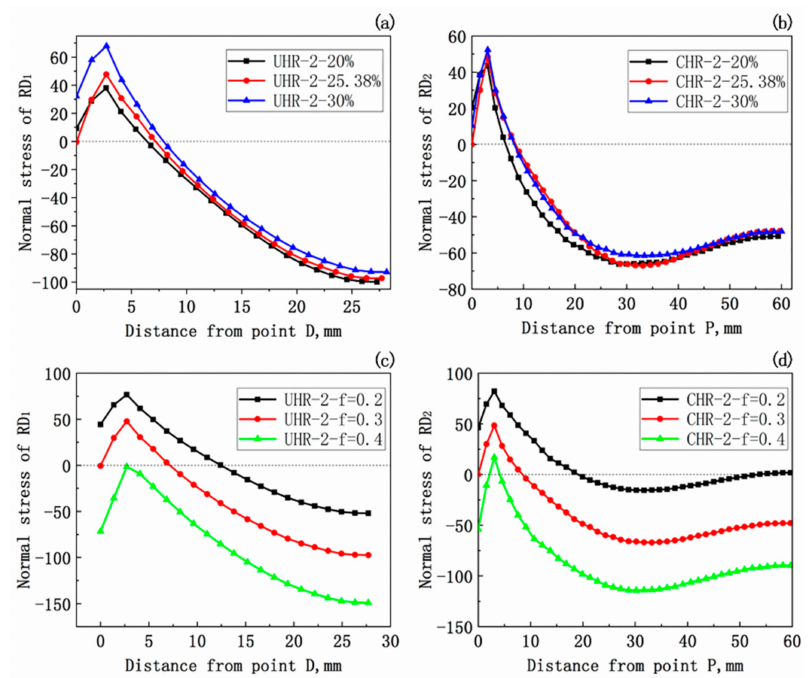
Figure 9. The effect of different parameters on the distribution of x-direction tensile stress along the width direction on the neutral surface under the two rolling modes: ( a,b ) reduction; ( c,d ) friction coefficient.